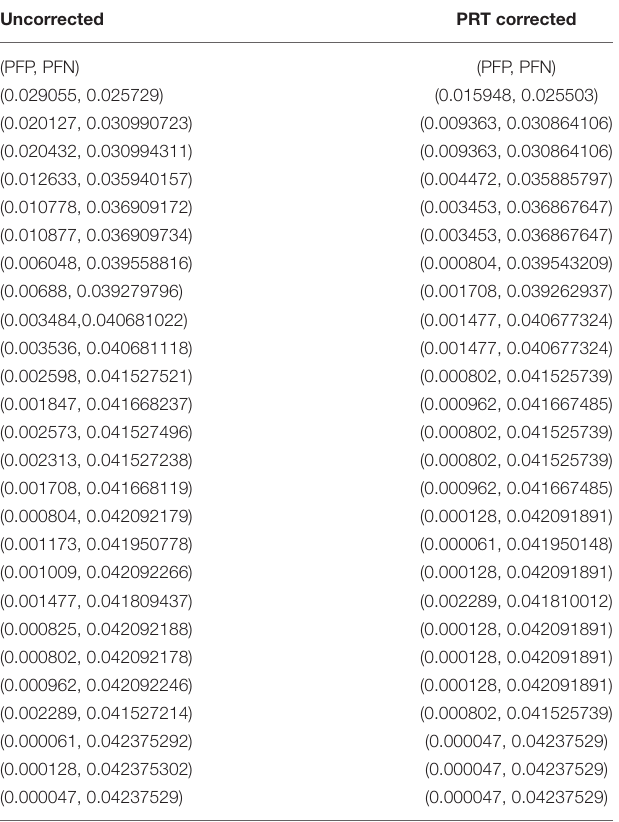
TABLE 3 | Comparison of statistical analysis results for the uncorrected and PRT correction. Uncorrected